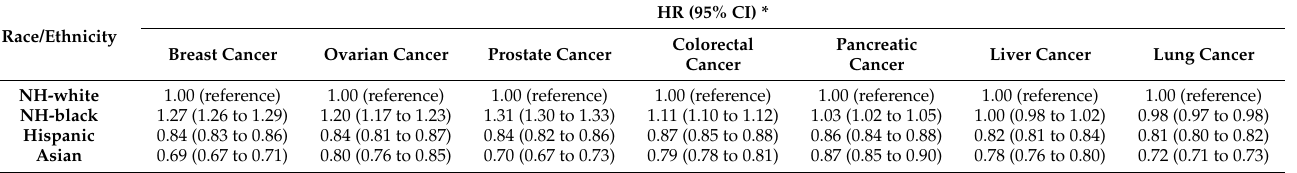
Table 2. Association of race/ethnicity with total mortality with adjustment for clinical characteristics. HR (95% CI) * Race/Ethnicity Breast Cancer Ovarian Cancer Prostate Cancer Colorectal Cancer Pancreatic Cancer Liver Cancer Lung